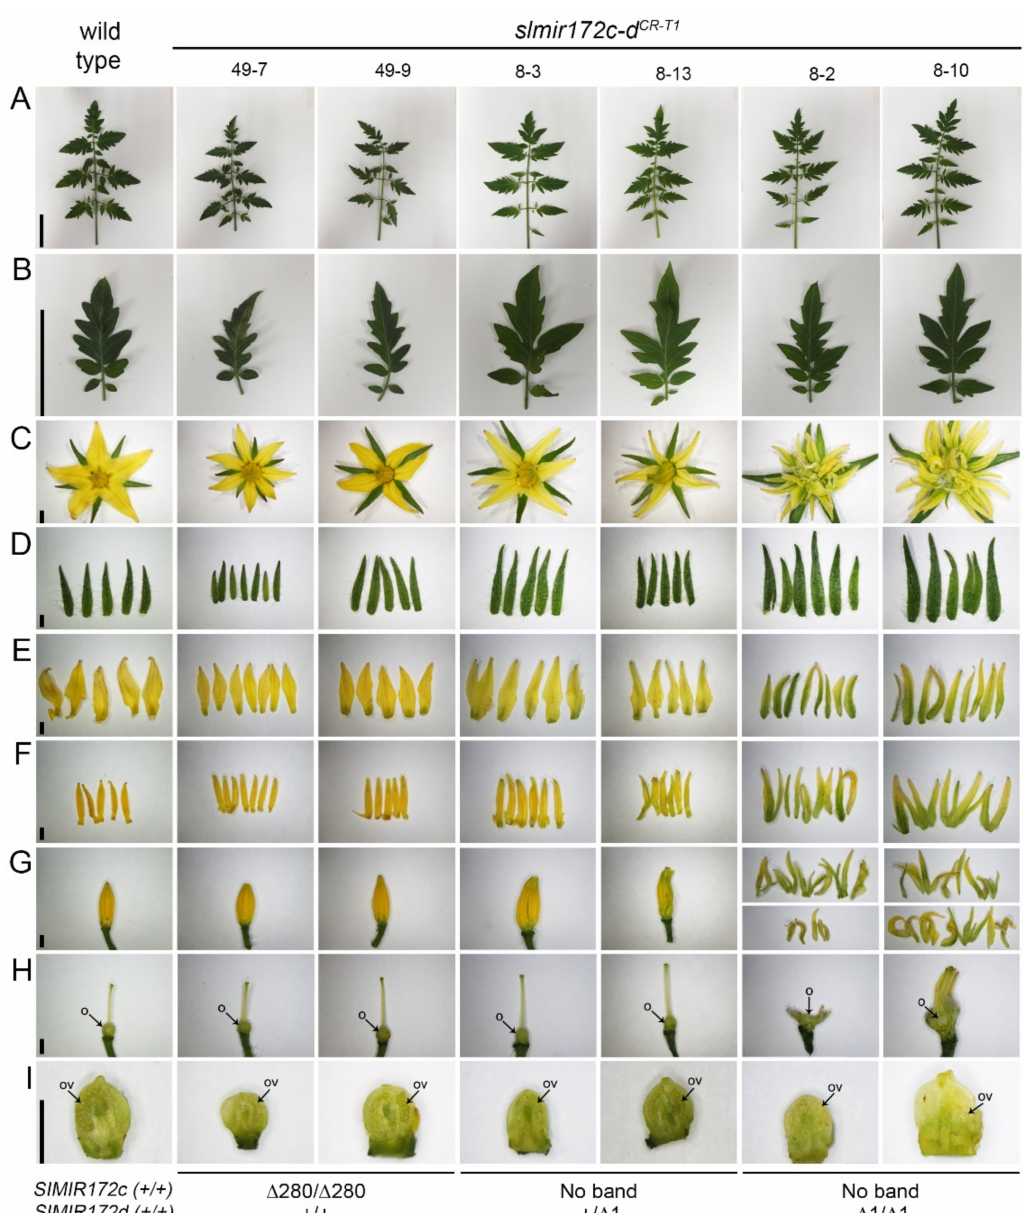
Figure 5. Leaf and flower phenotypes of slmir172c-d CR-T1 plants. ( A – I ) Representative pictures of wild type and indicated mutant plants fully expanded leaves ( A ), their terminal leaflets ( B ), anthesis flowers ( C ), their sepals ( D ), their petals or sepaloid organs ( E ), their stamens or sepaloid organs ( F ) their anther cone or sepaloid organs ( G ), their pistils ( H ) and manual longitudinal section of corresponding ovaries ( I ). O: ovary; OV: ovule. Scale bars = 5 cm for ( A , B ); 2 mm for ( C – I ). The genotype of each plant is marked at the